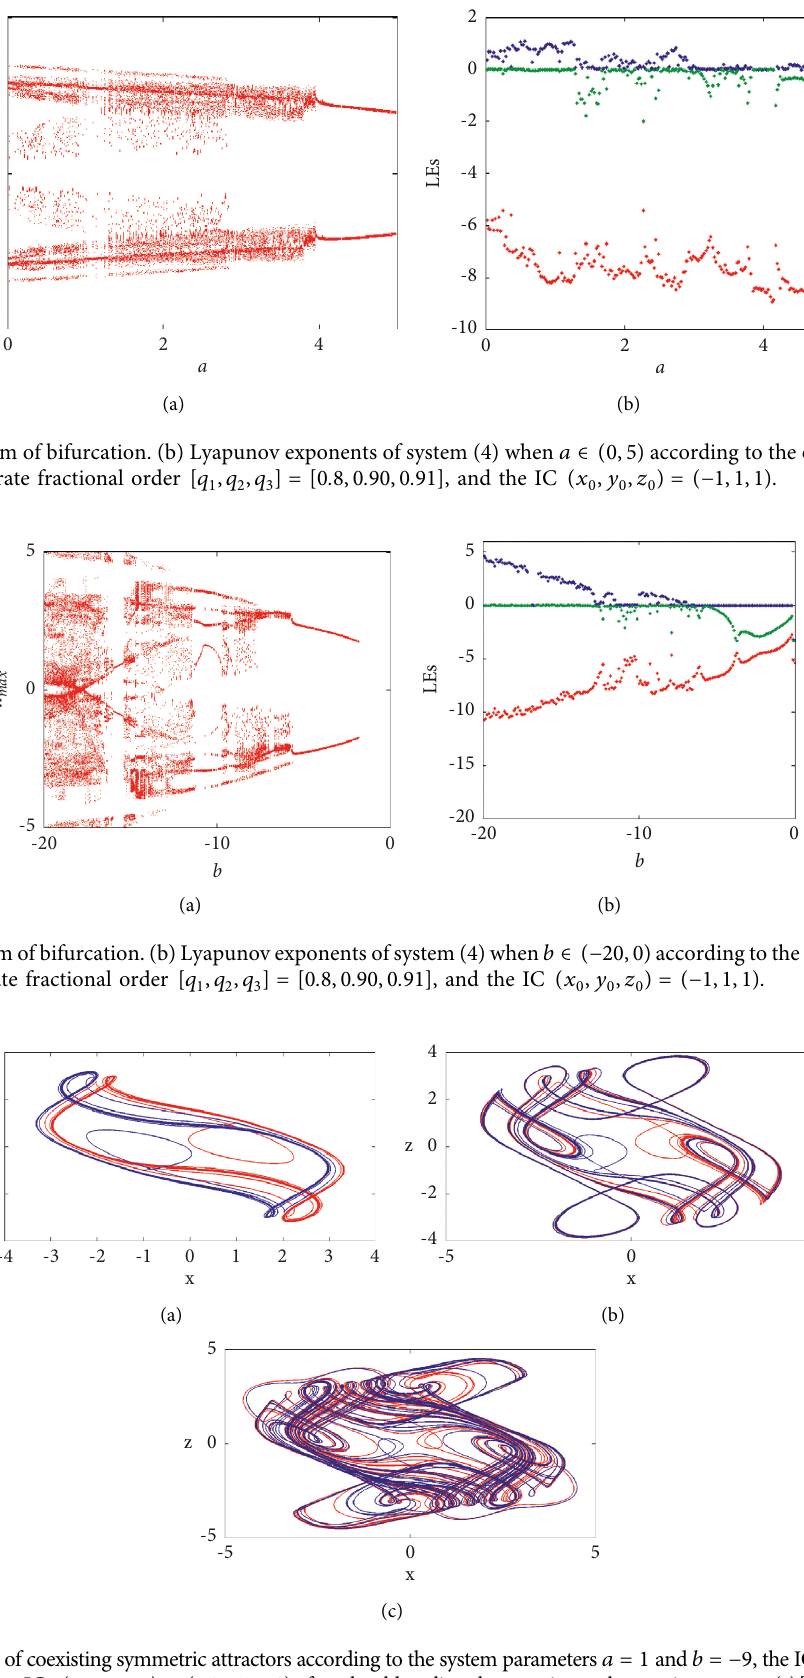
,y , z ) � (− 1 , − 1 , − 1 ) for the blue line by continuously varying q 0 0 0 , q , q ] � [ 0 . 89 , 1 , 1 ] 1 2 3